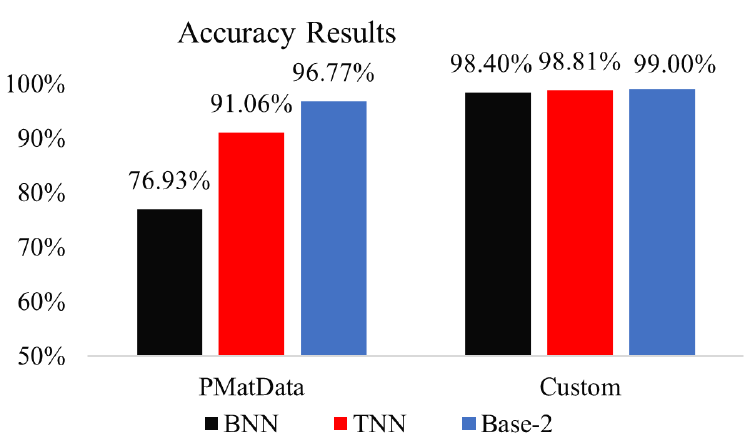
Figure 4. Comparisons between binary, BNN, ternary, TNN, and the proposed base-2 quantization in terms of accuracy. The models have been trained and tested on all the classes of the datasets. The accuracy has been estimated by using k -fold cross validation with k = 10 for the PMatData and k = 5 for the custom